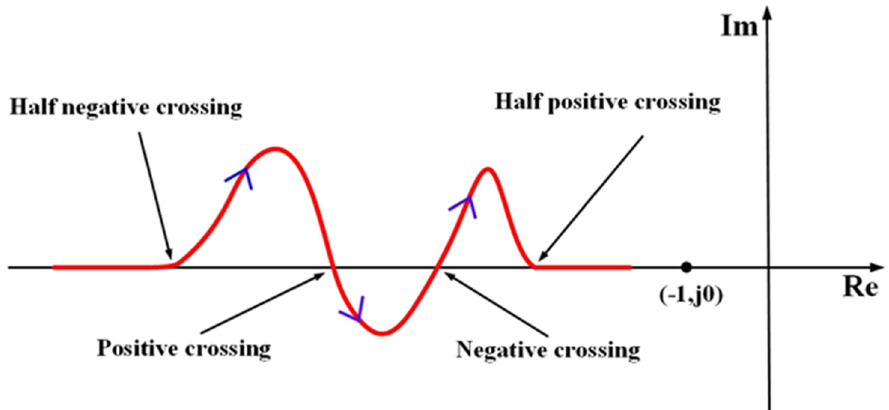
Figure 7. Overview of crossing manner (The arrow denotes the increasing ω ).